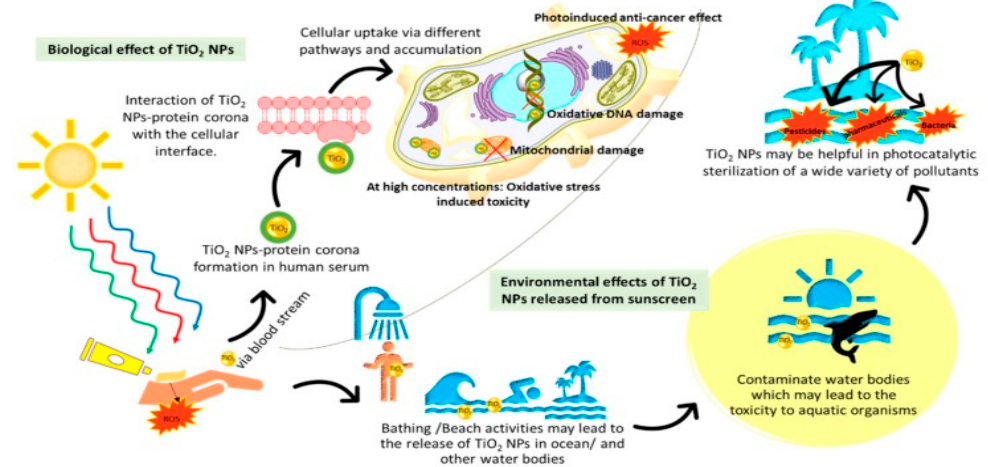
Figure 9. Environmental and biological effects of the TiO 2 NPs. Adapted with permission from [24]. Copyright, 2019 MDPI AG